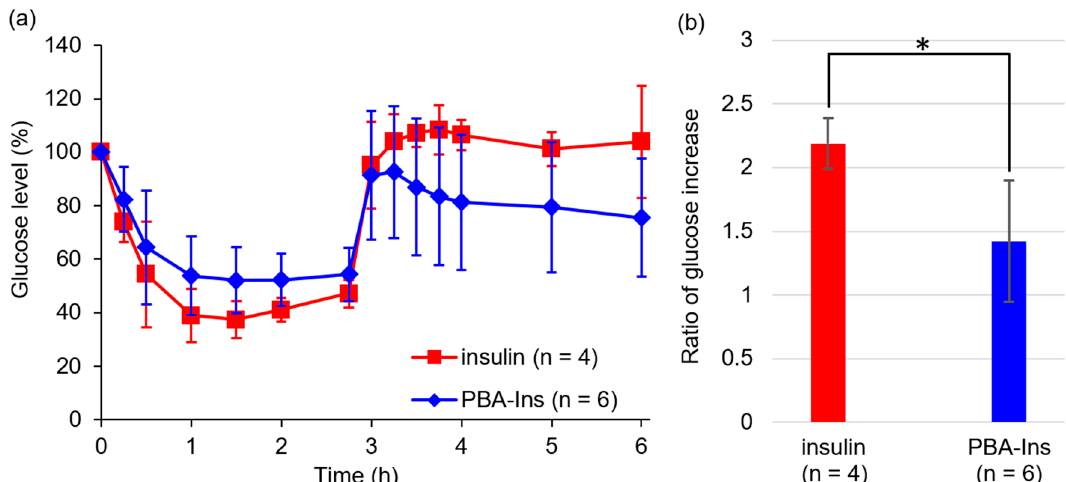
Figure 4. The effect of abdominal injection of glucose (1.00 g/kg) at 2.75 h after intravenous injection of insulin or PBA-Ins (190 µg/kg). ( a ) Profile of blood glucose level. Each value presents mean ± S.D. ( n = 4 or 6). ( b ) The ratio of glucose increase, which was calculated by dividing glucose level (6 h) by glucose level (2.75 h). * means p < 0.05 calculated using Student’s t -test.